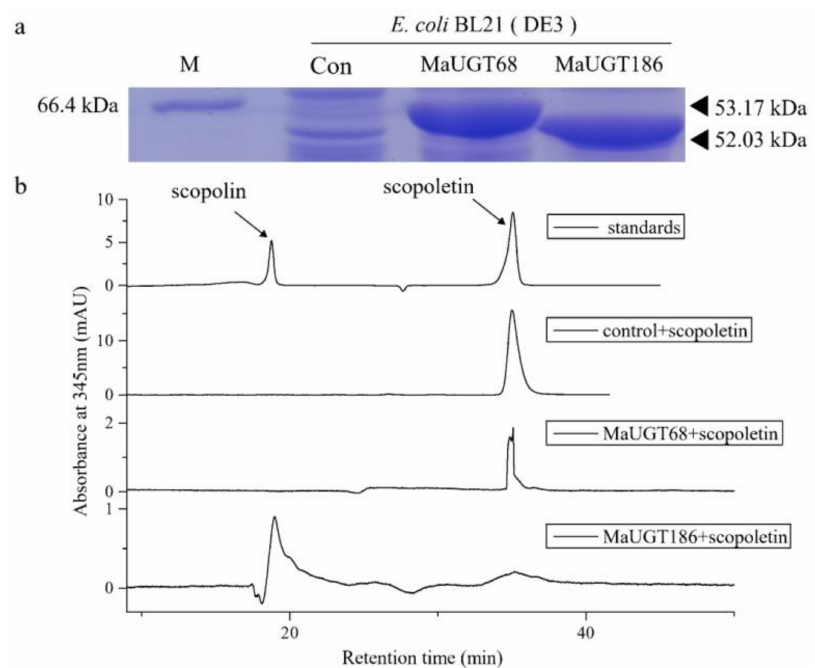
Figure 7. In vitro assay of MaUGT68 and MaUGT186 activity. ( a ). SDS–PAGE analysis of MaUGT68 and MaUGT186 heterologously expressed in E. coli . Expression of the proteins in E. coli BL21(DE3) was induced by IPTG for 18 h at 28 ◦ C. ( b ). HPLC analysis of the products from the glycosylation assays with MaUGT68 and MaUGT186. Extracts from incubation mixture containing the proteins together with scopoletin and UDP-glucose are compared with authentic scopolin and scopoletin standards. Incubation mixture with empty vector was used as